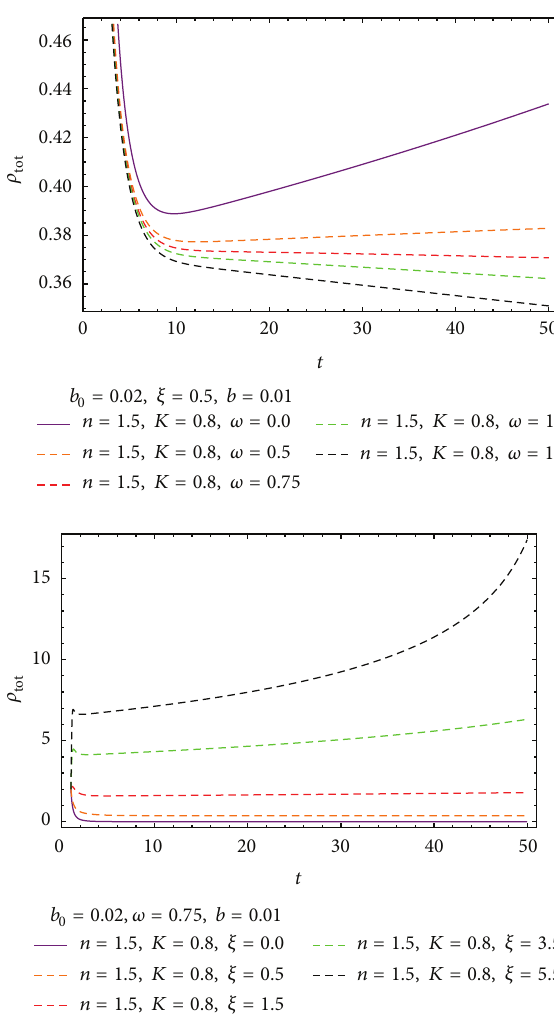
Figure 11: Behavior of 𝜌 against 𝑡 for interacting barotropic fluid and viscous polytropic tot